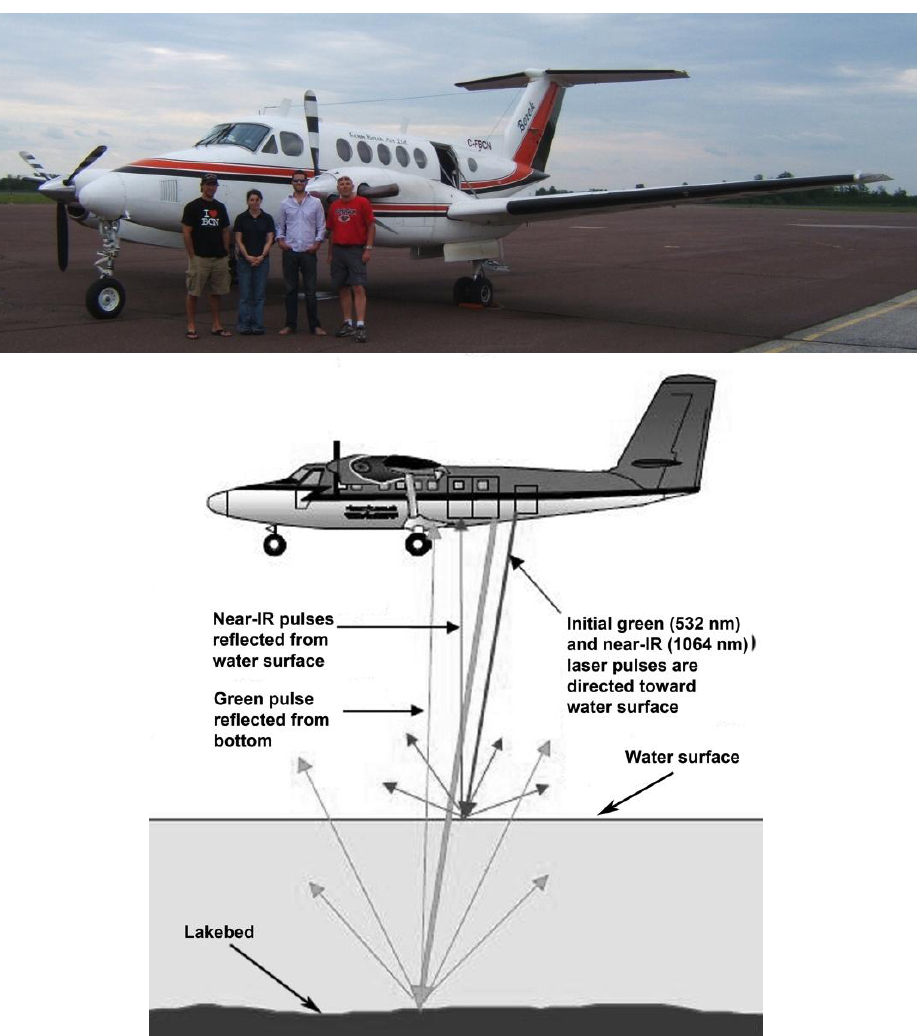
Figure 1. The Compact Hydrographic Airborne Rapid Total Survey (CHARTS) system (see the Methods) operated from a fixed wing King Air Beechcraft 2000, shown with the crew at the Houghton County Memorial Airport. For light detection and ranging (LiDAR), two laser pulses (blue-green 532 nm and near-IR 1,064 nm) are directed downward towards the lake water surface. The near-IR reflects from the water surface, whereas the blue-green penetrates through the water column and reflects off the lakebed. The difference between the two returning pulses gives the depth of the water column (bathymetry) and reveals the fine details of the benthic structure (the plane diagram is modified from LeRocque and West